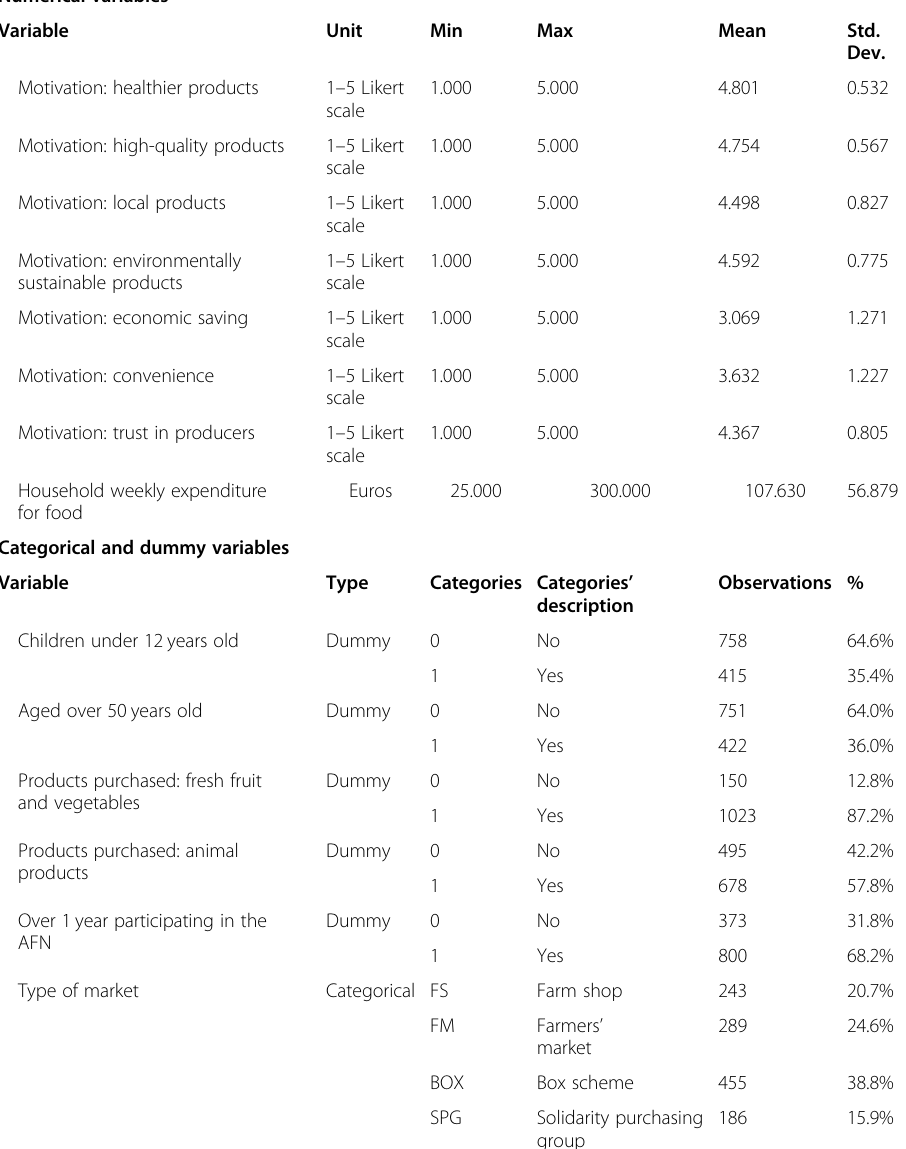
Table 3 Descriptive statistics of the factors Numerical